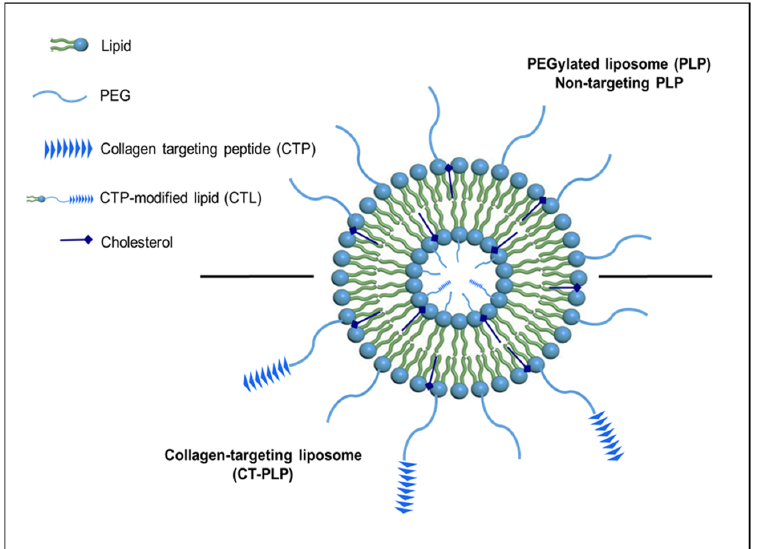
Figure 2. Schematic representation of collagen-targeting liposome (CT-PLP) and PEGylated liposome (PLP) controls. PLPs were assembled with bulk lipid DOPC and Chol at a mole ratio of 7:3 plus 10 mol % DSPE-PEG and 0.1 mol % rhodamine-DOPE for fluorescent labeling. CT-PLPs were formed likewise with the addition of CTP-conjugated CTL.